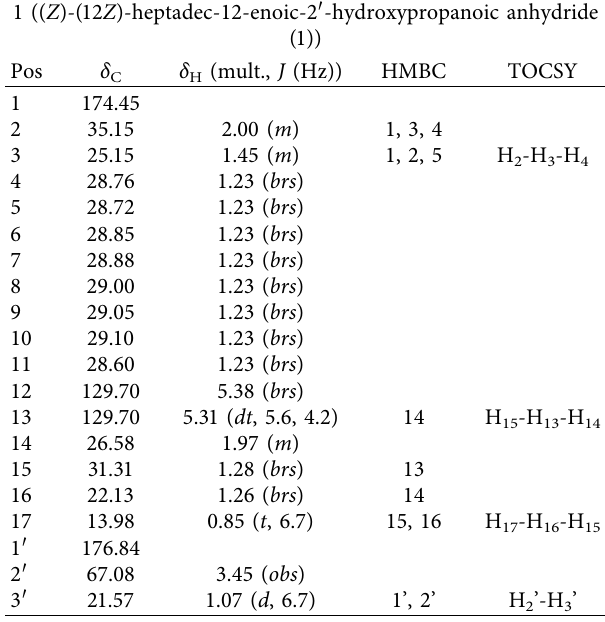
Table 1: 13 C (200 MHz, DMSO- d 1 H-NMR (800 MHz, 6 ) and DMSO- d 6 ) data for compound 1